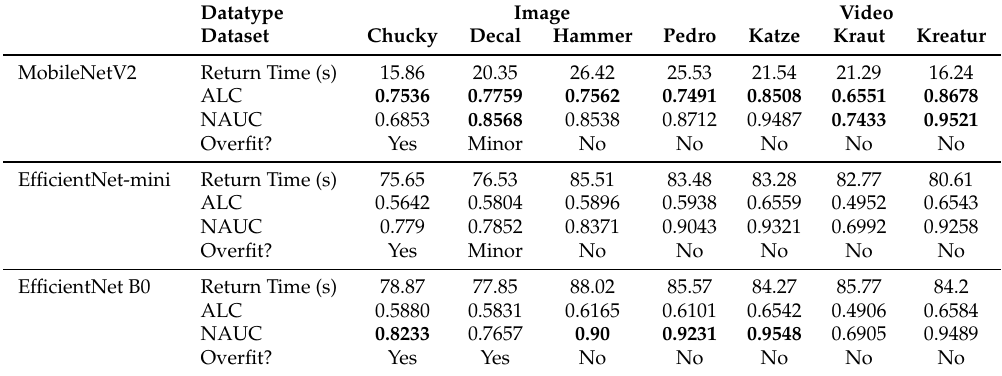
Table 2. Vision: Numerical evaluation of different network architectures on the image and video training